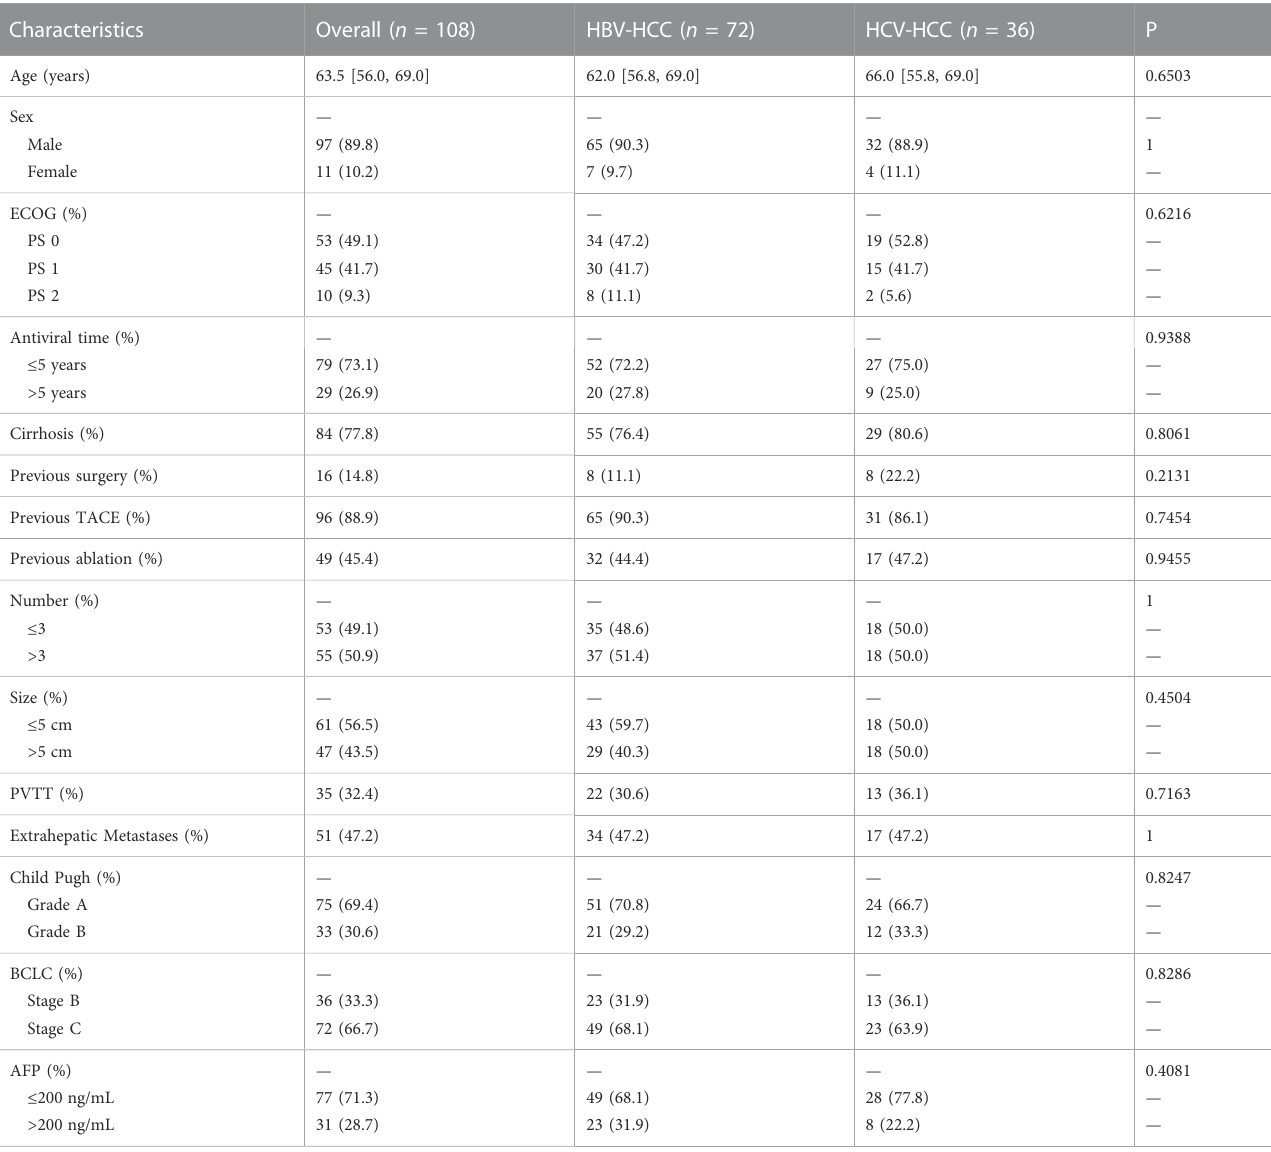
TABLE 1 Baseline characteristics between HBV-HCC and HCV-HCC.